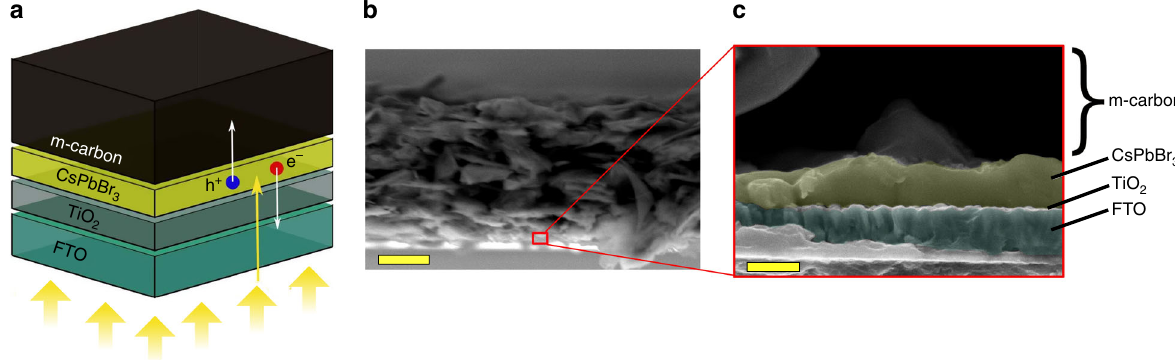
Fig. 1 Con fi guration of CsPbBr 3 devices. a Structure of standard carbon solar cell (illuminated through the FTO glass as indicated by the yellow arrows). Electron-hole (e − /h + ) pairs are generated in the CsPbBr 3 thin layer, then e − and h + are collected in the TiO 2 and m-carbon layers, respectively. b Cross- sectional scanning electron microscopy (SEM) image of the as-prepared CsPbBr 3 perovskite solar cell (scale bar 10 μ m). c Magni fi cation of the cross- sectional SEM image to show the FTO|TiO 2 |CsPbBr 3 interfaces (scale bar 500 nm)